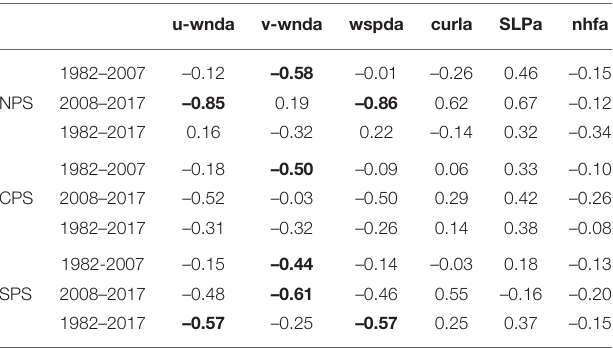
TABLE 5 | Linear correlation coefficients (r) between the time series of atmospheric forcing and SSTa at NPS, CPS, and SPS for different time periods: between 1982 and 2007, between 2008 and 2017, and for the full records between 1982 and 2017 (see Section 4.2.2). u-wnda v-wnda wspda curla SLPa